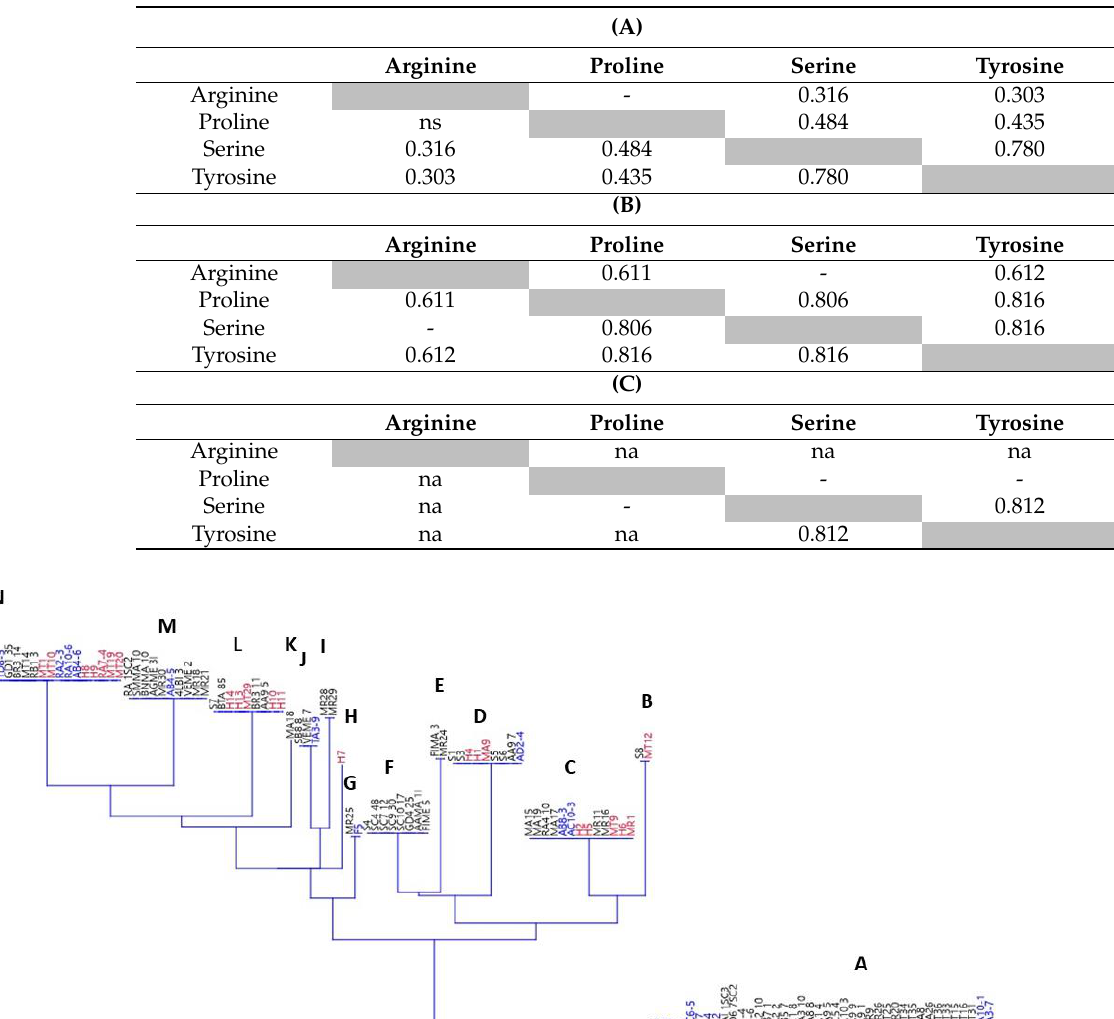
Table 4. Spearman’s rank order correlation amongst amino acids in S. cerevisiae ( A ); Z. bailii ( B ); and Hanseniaspora spp. ( C ). Only significant correlations are reported. -: not significant; na: not assessed.; and ns: not significant.